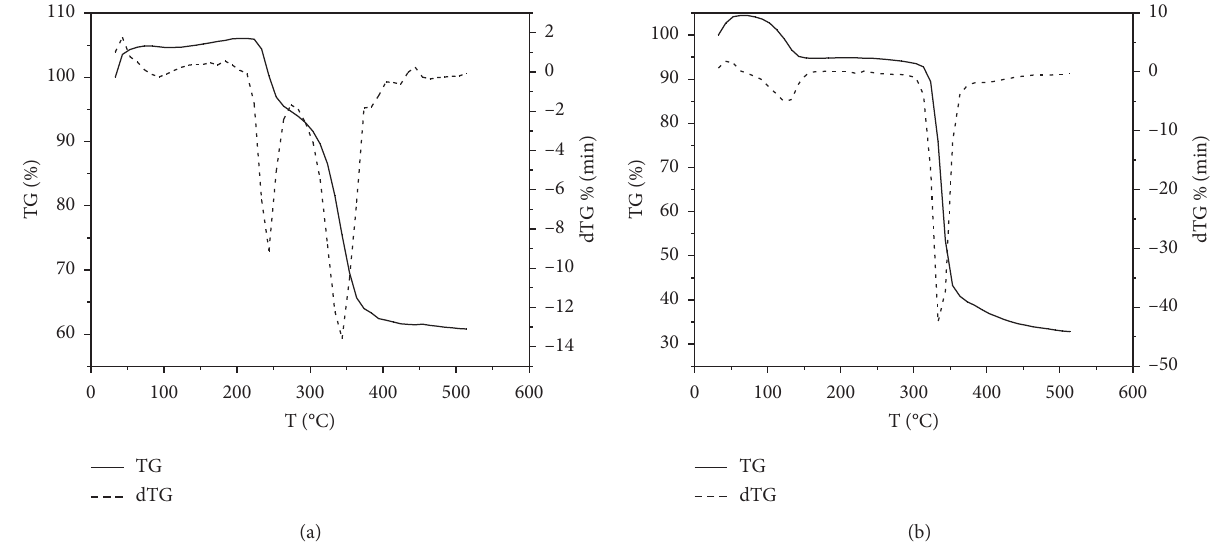
Figure 4: TG/DTG curves of the β -CD:VD 3 with a constant heating rate of 10 deg/min in a nitrogen medium: (a) physical mixture; (b) β -CD:VD 3 β -CD:VD 3 inclusion complex (2:1).